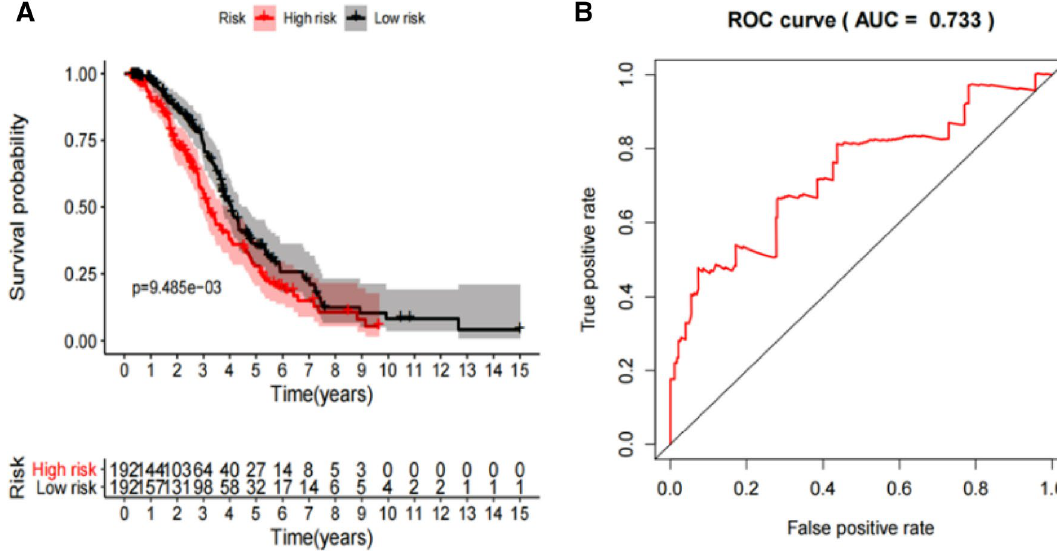
Figure 3. The K-M curve indicated the OS of high-risk patients (red line) and low-risk patients (blue line) based on 11-AS events ( A ). The ROC curve evaluated the predictive power of prognostic model and the risk score reflected the greatest prognostic power with an AUC of 0.733 ( B ).